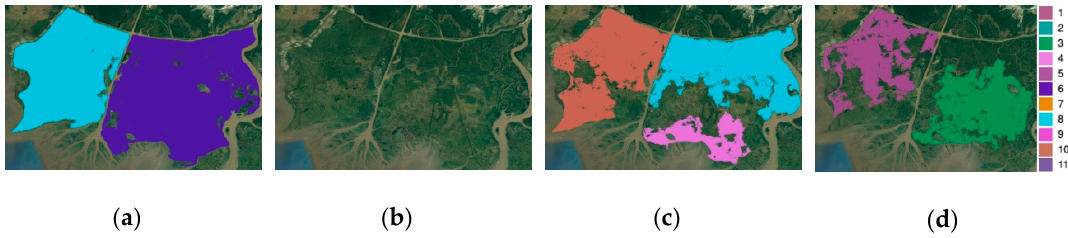
Figure 9. Examples of connected component maps. ( a ) One at west and one at east (2010.1.20~2010.3.7). ( b ) No valid components (2008.9.1~2008.10.17). ( c ) One at west; one at northeast, adjacent to the west component; one at southeast, not adjacent to other components (2008.3.1~2008.4.16). ( d ) One at west; one at southeast, not adjacent to other components (2008.7.17~2008.9.1). The coverage for ( a ~ d ) is the same as Figure 1. Colors are used to distinguish di ff erent connected components only. (Background Map from Google [26]).